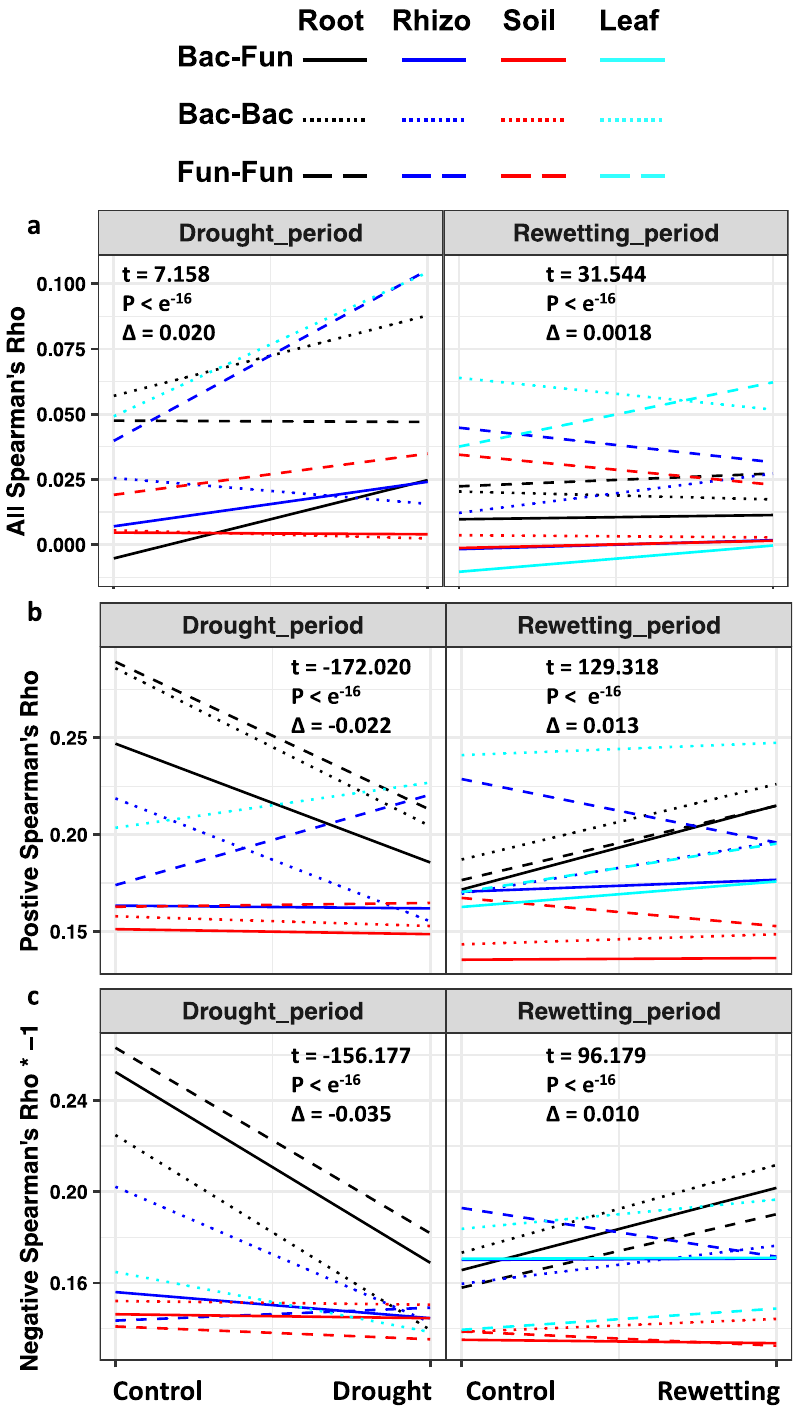
Fig. 2 Correlations of microbes in drought stress and drought relief. Estimates of combined correlations (row a) show an increase in positive correlations under drought stress across the four compartments (root, black; rhizosphere, blue; soil, red; leaf, green). Data points underlying the lines in the fi gure are provided in the alternative version in Supplementary Fig. 2. This result is in line with the stress gradient hypothesis which posits that stressful environments favor positive associations because competition will be less intense than in benign environments 32,33,36,37 . Note that positive trends in combined correlations can arise in two ways. First, from an increase of positive correlations (row b) that exceeds the rise in negative correlations (row c), e.g., Leaf bacterial-bacterial (Bac-Bac) correlations or rhizosphere fungal-fungal (Fun-Fun) correlations in the drought period (Negative correlations in row C values are multiplied by − 1 to facilitate comparison). Second, from a decrease in negative correlations that exceeds a decrease in positive correlations, e.g., root bacterial-bacterial correlations or root bacterial-fungal (Bac-Fun) correlations in drought. Combined (a), positive (b) and negative (c) estimates of correlation (Spearman ’ s rho, ρ ) are given for four compartments (root, rhizosphere, soil and leaf), and three types of correlations (Bacterium-Bacterium, Fungus-Fungus, Bacterium-Fungus). T-tests (two sided) were carried out for linear mixed effect modelling that incorporates link type and compartments as random factors. Detailed distribution densities of correlations are presented in Supplementary Fig. 3. Source data are provided as a Source Data fi le.